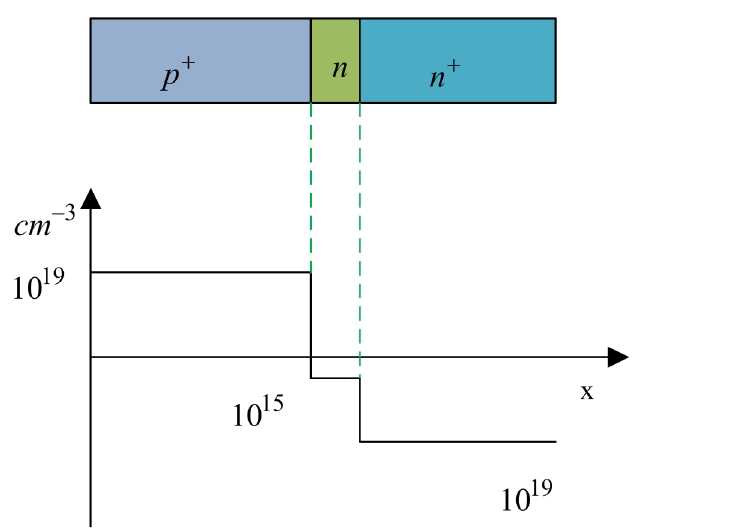
Fig 1. Impurity profile of